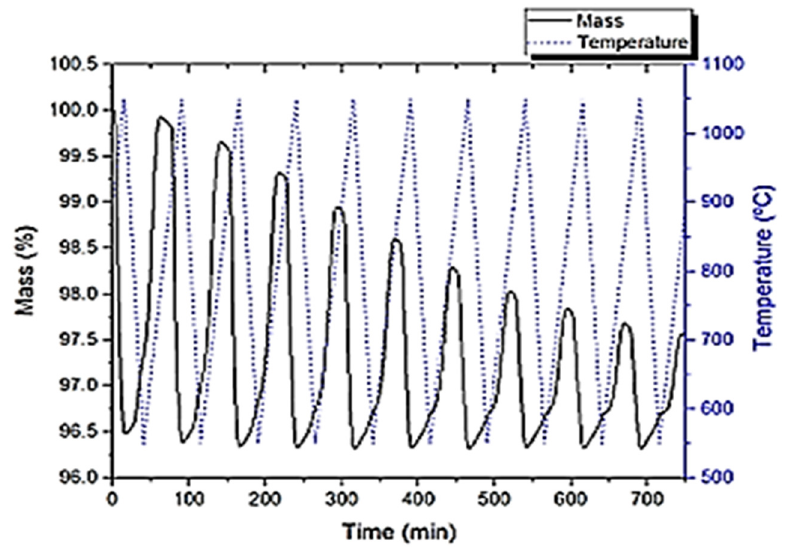
Figure 7. Weight-change curves during 10 Mn 2 O 3 /Mn 3 O 4 TGA cycles between 500 and 1100 °C [109].